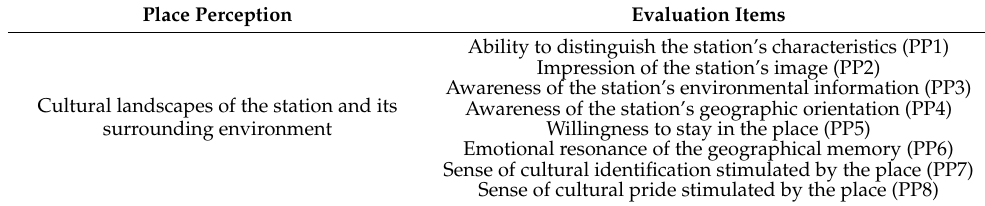
Table 5. Evaluation indexes of place